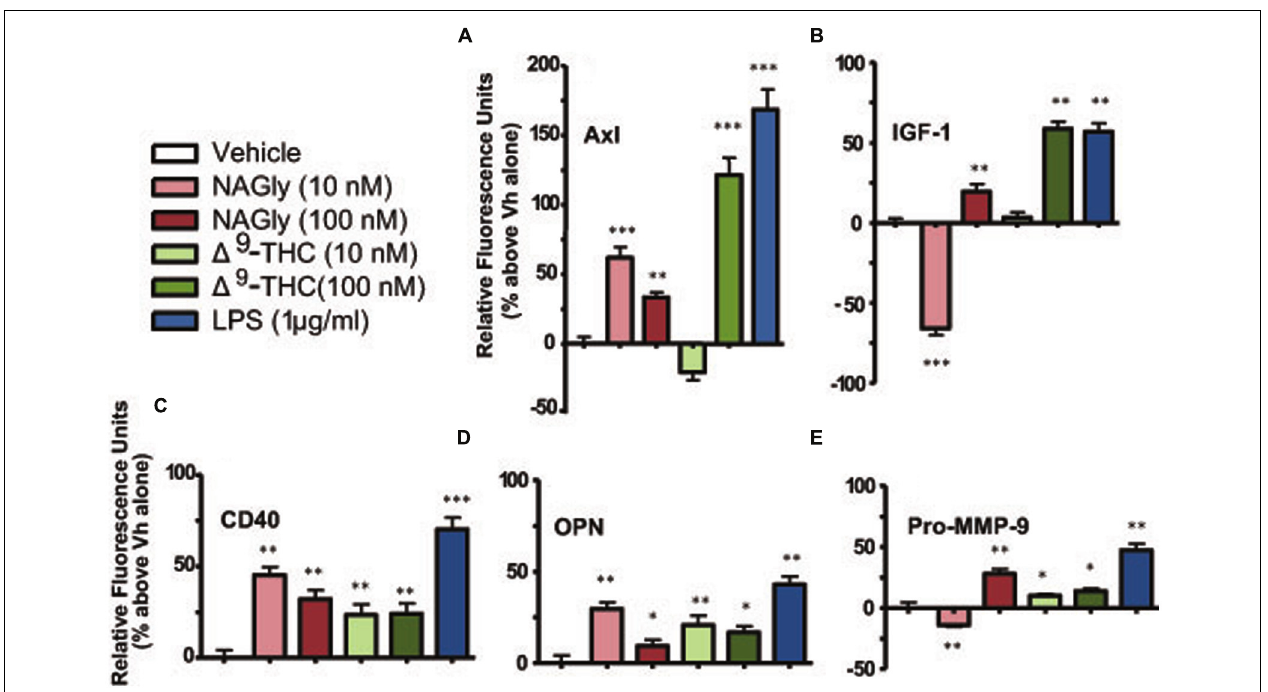
FIGURE 3 | Levels of cytokine production after 3 h treatment in BV-2 microglia. (A) Axl, (B) IGF-1, (C) CD40, (D) OPN, (E) Pro-MMP-9. NAGly (10 nM and 100 nM) and (cid:2) 9 -THC (10 nM and 100 nM). n = 4–5. * p < 0.05, ** p < 0.01, *** p < 0.001 (One-way